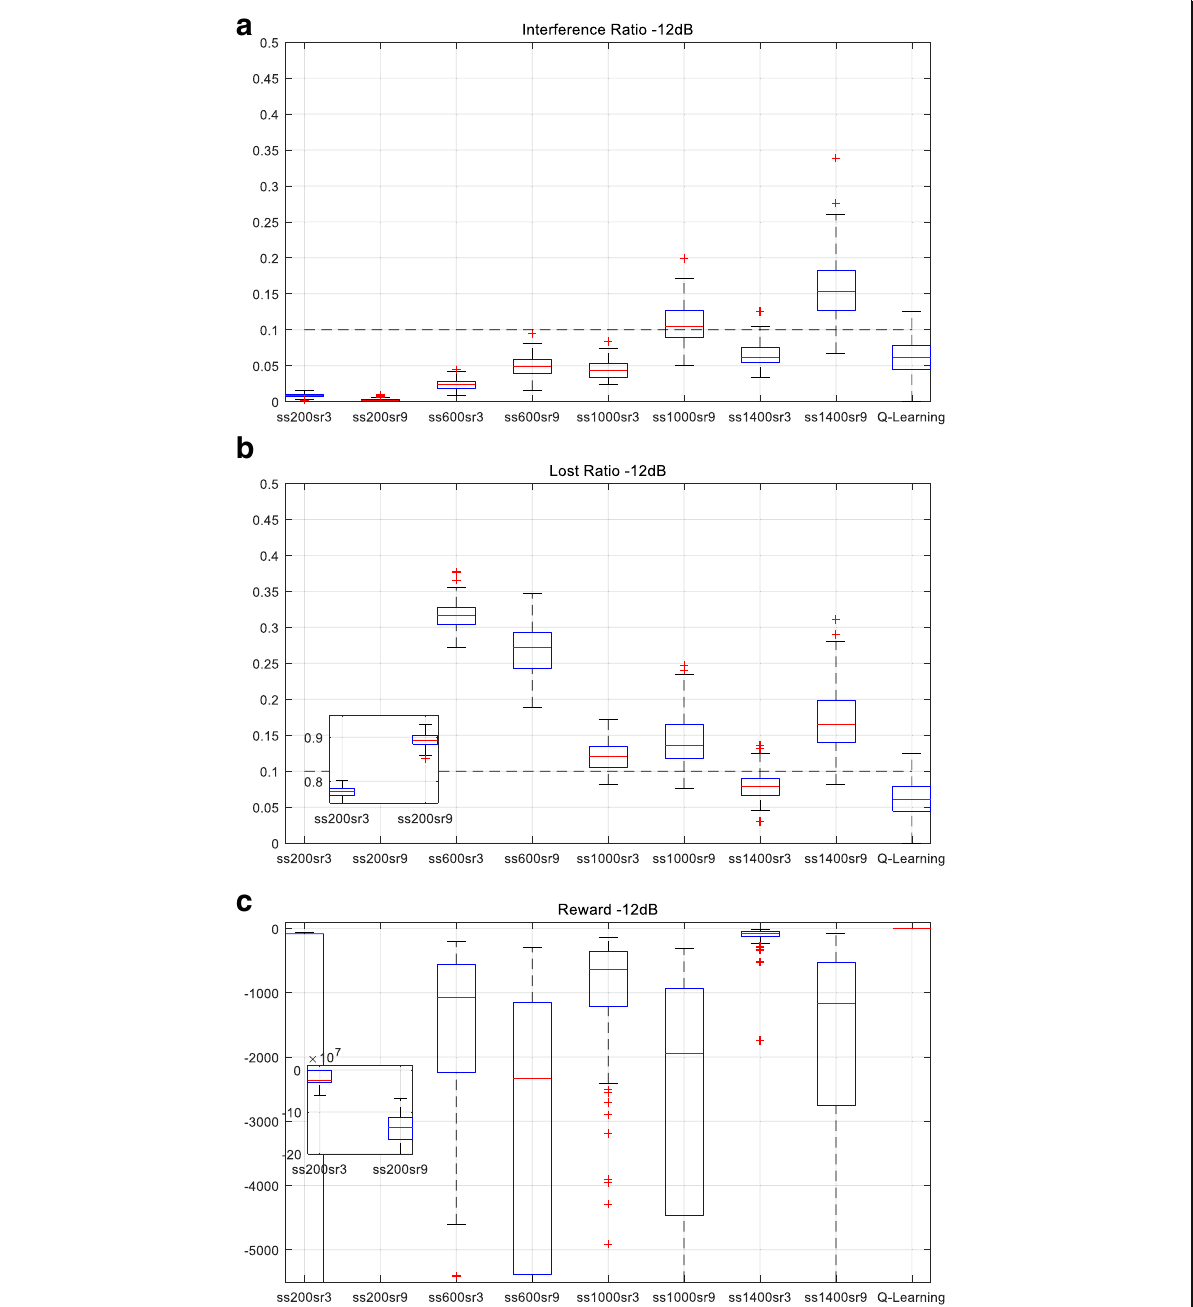
Fig. 14 Interference ratio, transmission opportunity loss ratio, and reward of the fixed case and Q-learning @ − 12 dB. a Interference radio. b Transmission opportunity loss ratio. c Reward. The performance of the interference ratio, transmission opportunity loss ratio, and reward is compared for cases where the sensing time and the reply time are fixed and the proposed Q-learning is used for SNR of − 12 dB. In a representing the interference ratio and b representing the transmission loss ratio, the Q-learning operates within a stable range. For the case where the sensing time and the reapply time are fixed, the interference ratio is low, but the transmission opportunity loss ratio increases significantly in most cases. In c indicating a reward, the Q-learning shows overwhelming performance difference compared to other cases. Thus, it can be shown that the system load can be reduced by using